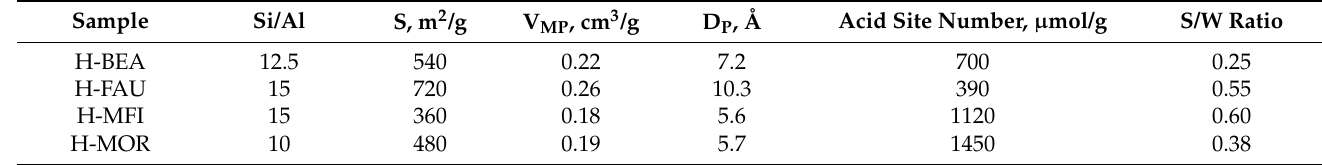
Table 1. Textural and acidic properties of